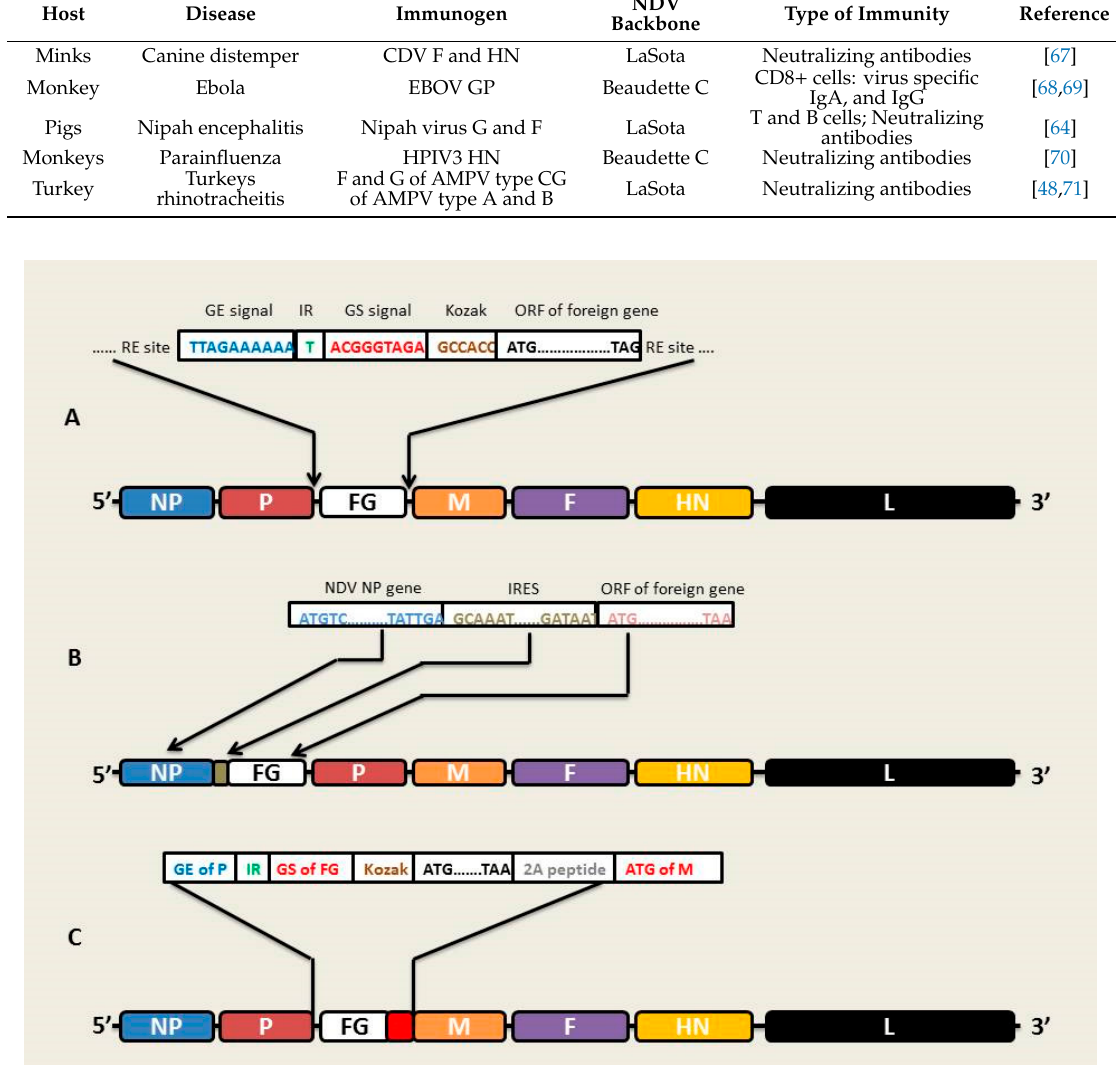
Figure 2. Strategies for foreign gene (FG) expression using NDV as a vector. ( A ) Expression of a foreign gene (FG) as an additional transcription unit. The FG along with NDV transcriptional signals and a Kozak sequence is cloned in a non-coding region, preferably between the P and M genes. ( B ) IRES-mediated expression of an FG. An IRES sequence is placed in between the coding regions of any NDV gene and the FG. ( C ) Expression of an FG via 2A peptide-mediated fusion with any NDV gene.